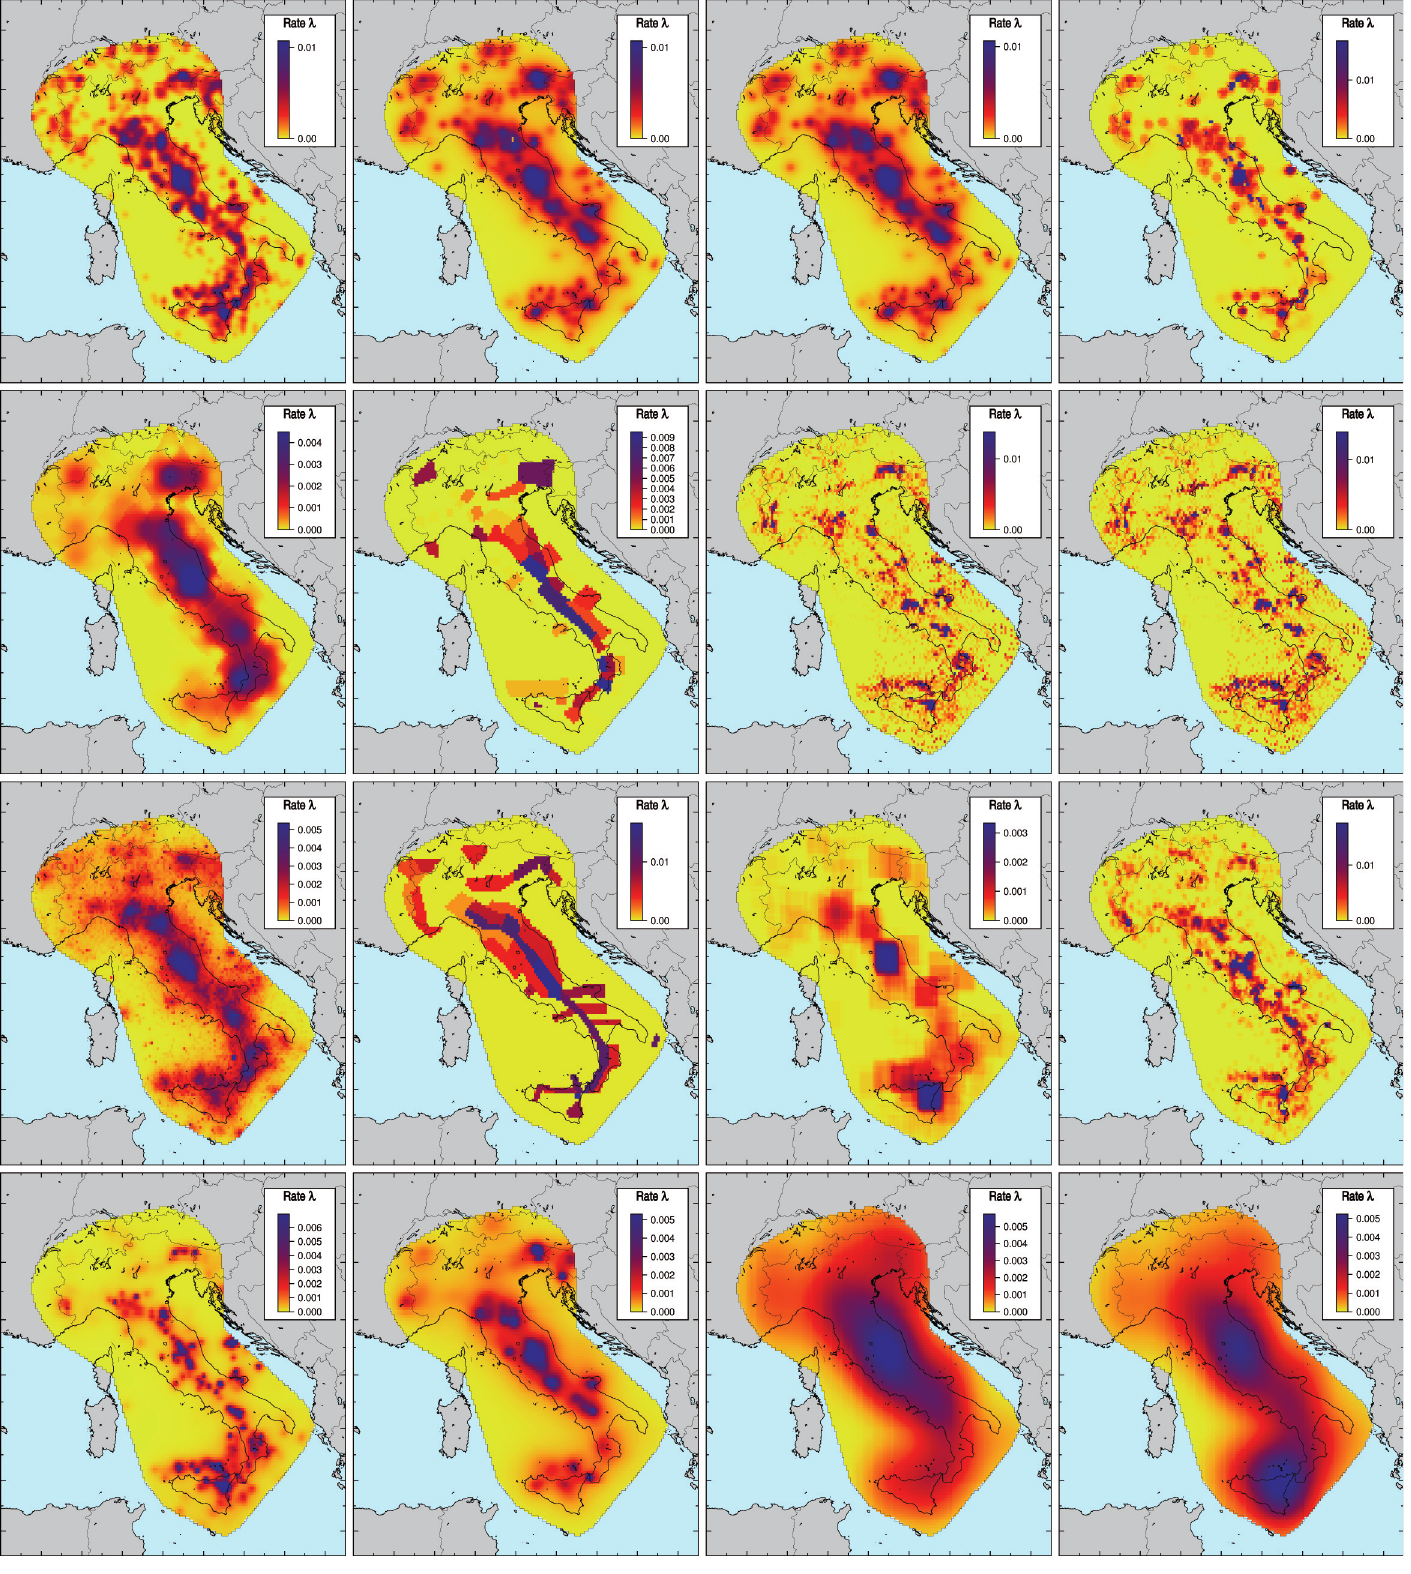
Figure 2. 16 of 18 the forecast models submitted for the Italian testing region. Color coded are the rates of forecast events for the next 5 years (note: scales are not the same). Prospective testing of these models commenced on August 1, 2009, and will last for 5 years. From upper left, moving right and down: HAZGRIDX, HZA_TD, HZA_TI, LTST, PHM_Grid, PHM_Zone, ALM, HALM, DBM, MPS04, RI, ALM.IT, HiResSmoSeis-m1, HiResSmoSeis-m2, TripleS-CPTI,